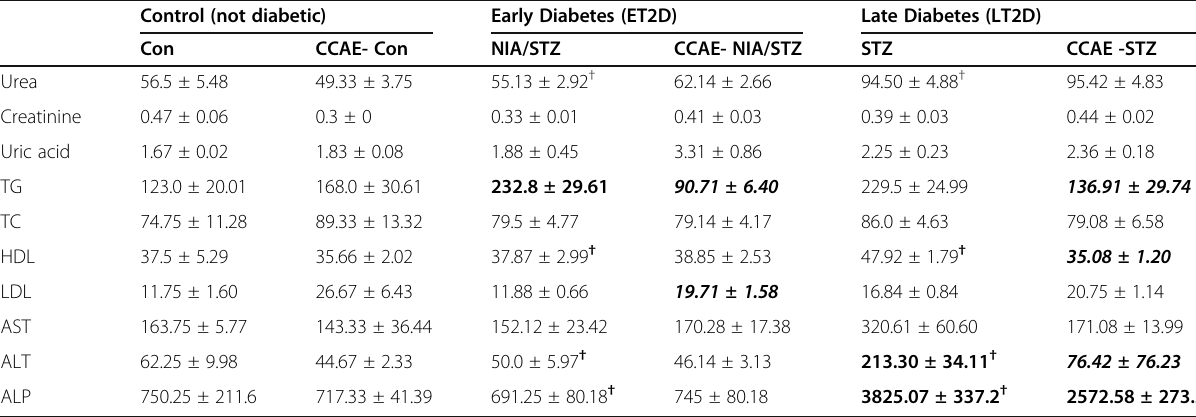
Table 3 Fasting blood chemistry on day 28 Control (not diabetic) Early Diabetes